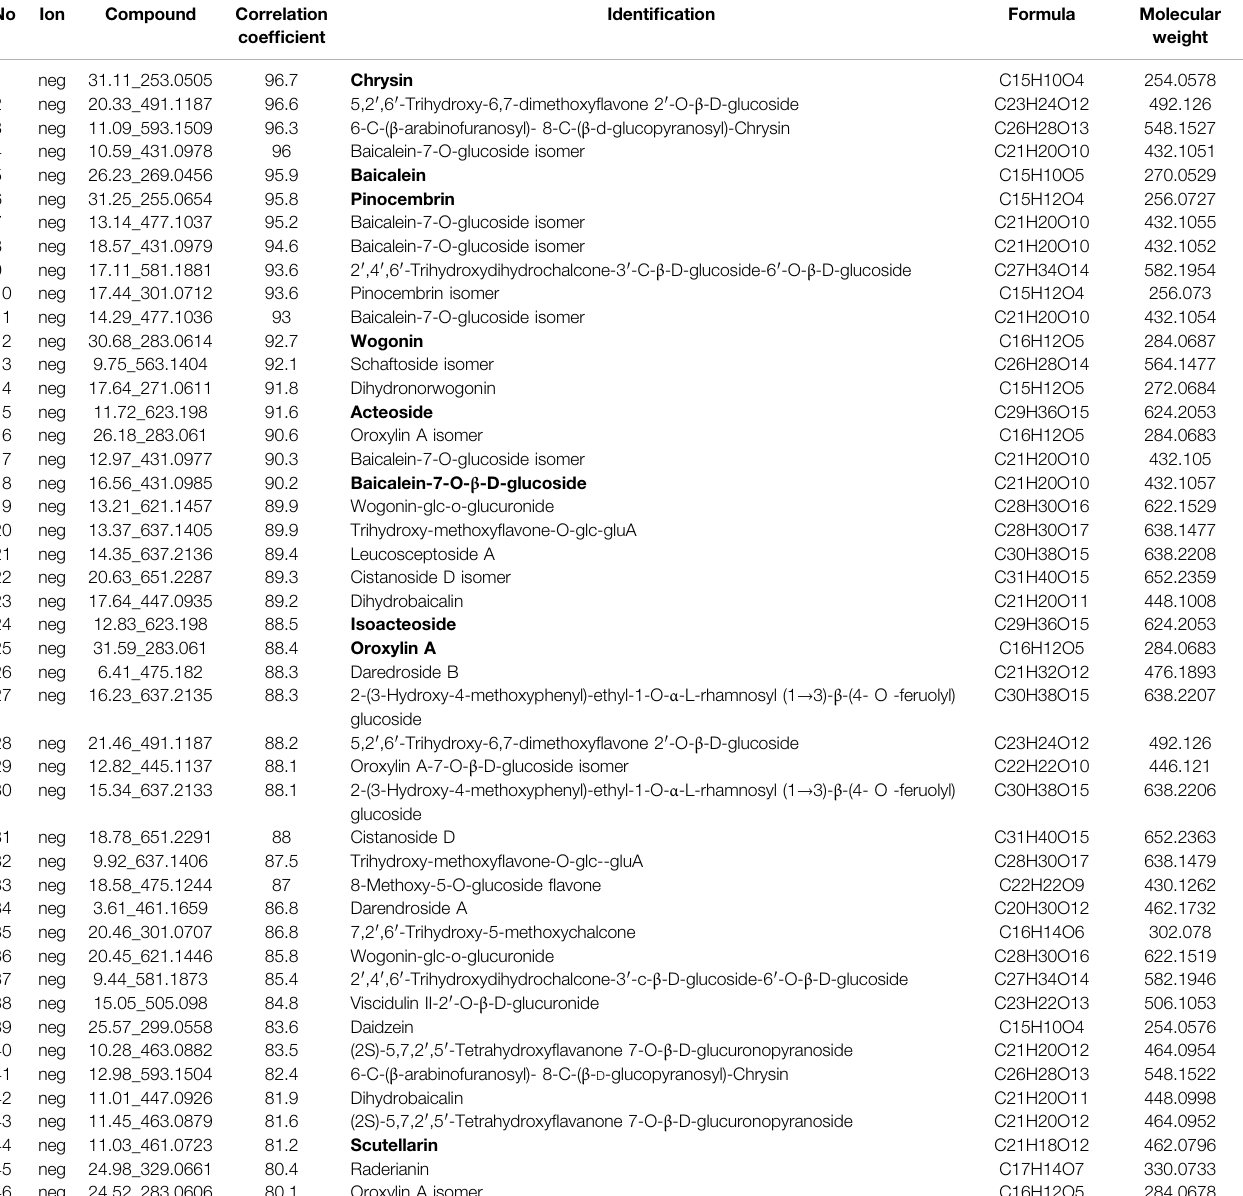
TABLE 1 | Identi fi cation of components with score ≥ 80 in correlation analysis of plant metabolomics and pharmacodynamics (negative mode). No Ion Compound Correlation coef fi